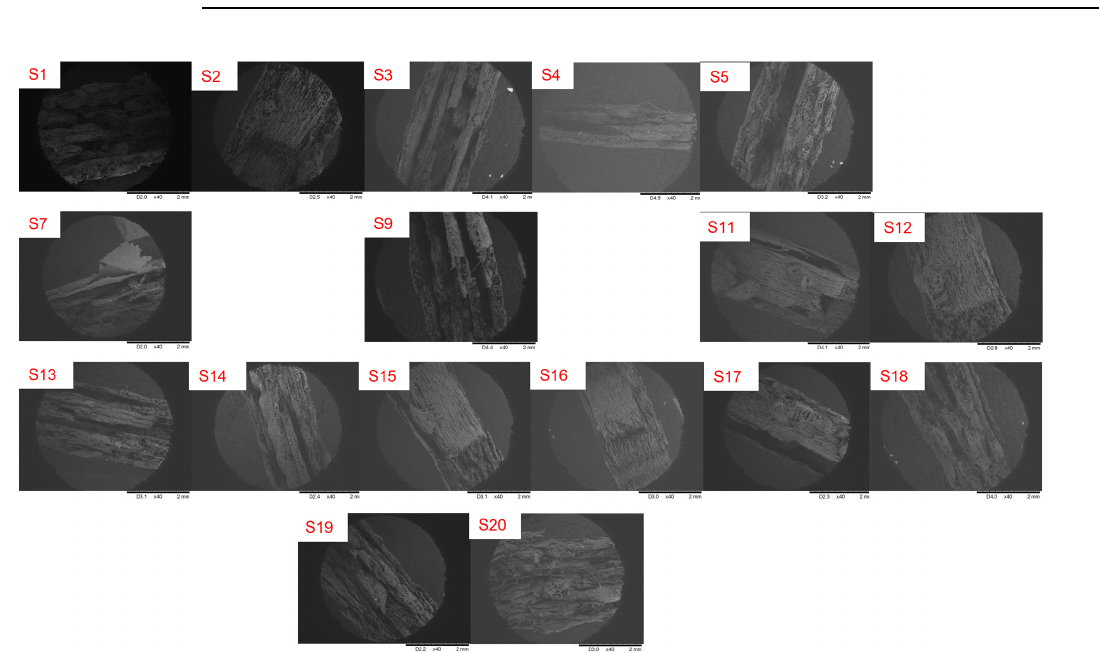
Figure 3. Micrograph cross-sectional images of the PACF composites with different printing parameters (refer to Table 1).